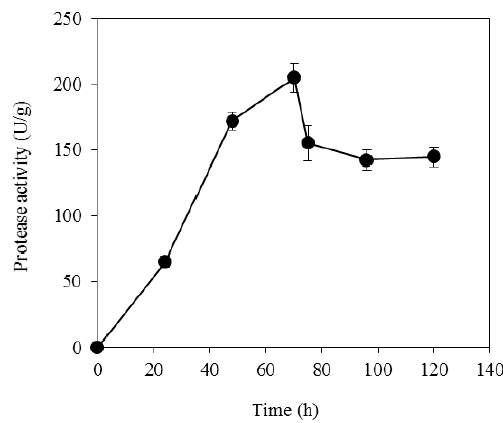
Figure 6. Proteolytic activity (U/g of fermented solids) of A. oryzae during solid-state fermentation of soybean cake.